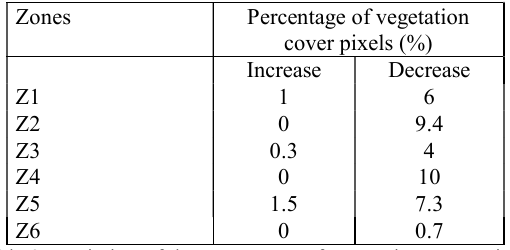
Table 2. Variation of the percentage of vegetation cover pixels between the spring of 2016 and the spring of 2019 by zone In order to illustrate the abrupt change in the vegetation cycle observed in the autumn of 2018 and related to heavy rainfall episode mentioned above (Figure 5, Figure 6), the map detection change of vegetation cover is calculated between the autumn of 2016 and the autumn of 2018 (Figure 9). Phyto- stabilized zones (Z1, Z3 and Z5) and zone 3 have between 11 and 22% of pixels with increasing vegetation cover. Zones 4 and 6 have between 40 and 45 % of pixels with increasing vegetation cover.